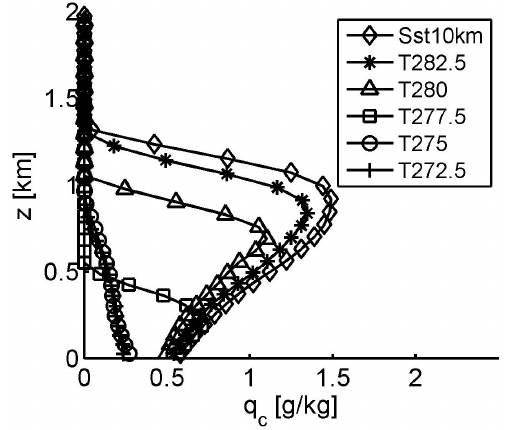
Fig. 12. Vertical profiles of q c at the position of their maximum intensity at 04:00h, for simulations with l sst = 10km and varying T s .